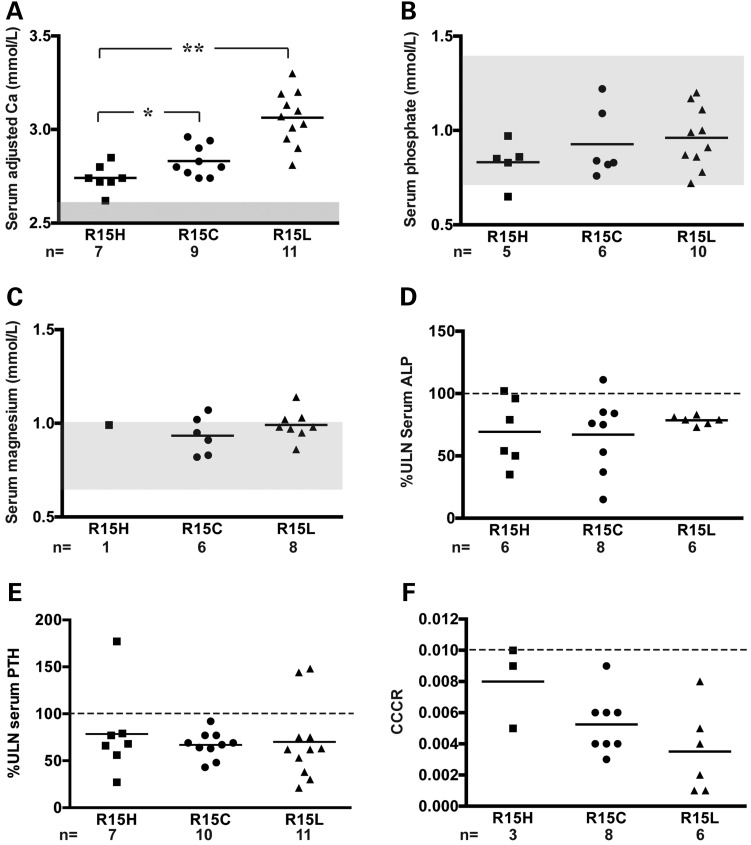
Assessment of genotype–phenotype correlations between probands harbouring Arg15His (R15H), Arg15Cys (R15C) or Arg15Leu (R15L) AP2S1 mutations. Serum and urine biochemical values are shown as scatter plots. (A) Probands with R15L mutations had significantly greater elevations of serum adjusted-calcium concentrations than probands with R15C or R15H mutations. Probands with R15C mutations were significantly more hypercalcaemic than probands with R15H mutations. (B–F) No significant differences in serum concentrations of phosphate, magnesium, ALP activity, PTH or urinary CCCR were observed between probands harbouring each of the three AP2S1 R15 mutations. Mean values for the respective groups are indicated by horizontal solid lines. The normal ranges [mean ± 2 standard deviations (SDs)] for serum calcium, phosphate and magnesium are indicated by the grey areas. The upper limit of normal (ULN) for the assay that was used for serum ALP activity and PTH concentrations are represented by the broken line. For CCCR, the lower limit (<0.01) for the consideration of hypocalciuria is represented by the broken line. *P < 0.05, **P < 0.01.